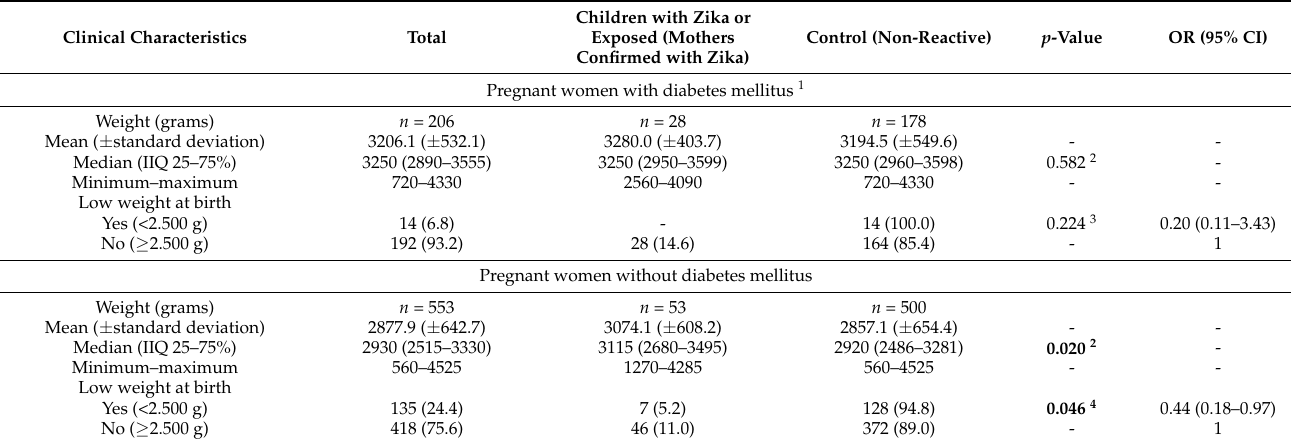
Table 3. Association of birth weight between positive/exposed newborns and control newborns according to maternal diabetes, Junida í Medical School, 2016–2019.